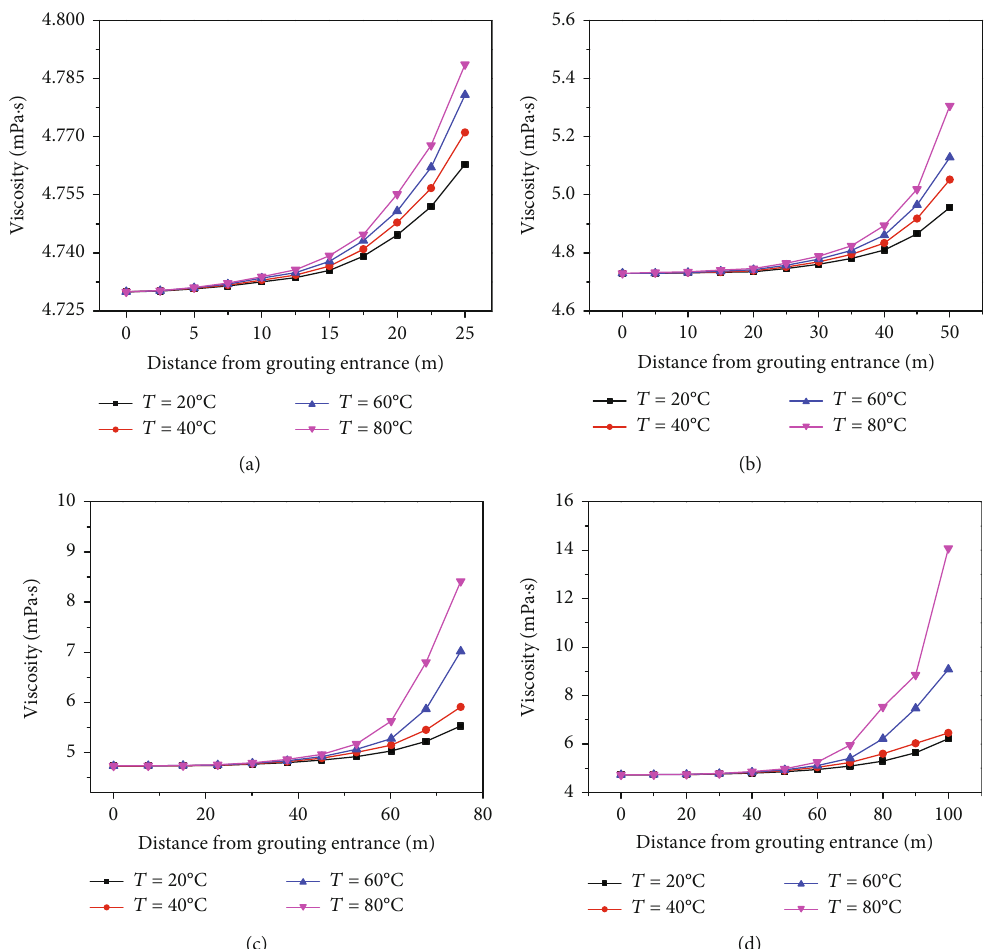
Figure 6: The dynamic viscosity of the grout reaching di ff erent distances in the fracture with di ff erent lengths: (a) 25m, (b) 50 m, (c) 75 m, and (d)